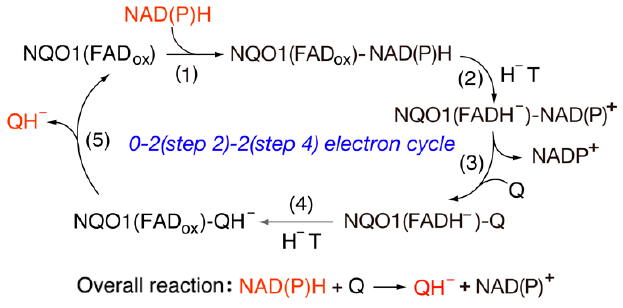
Figure 8. Proposed catalytic cycle of NQO1.